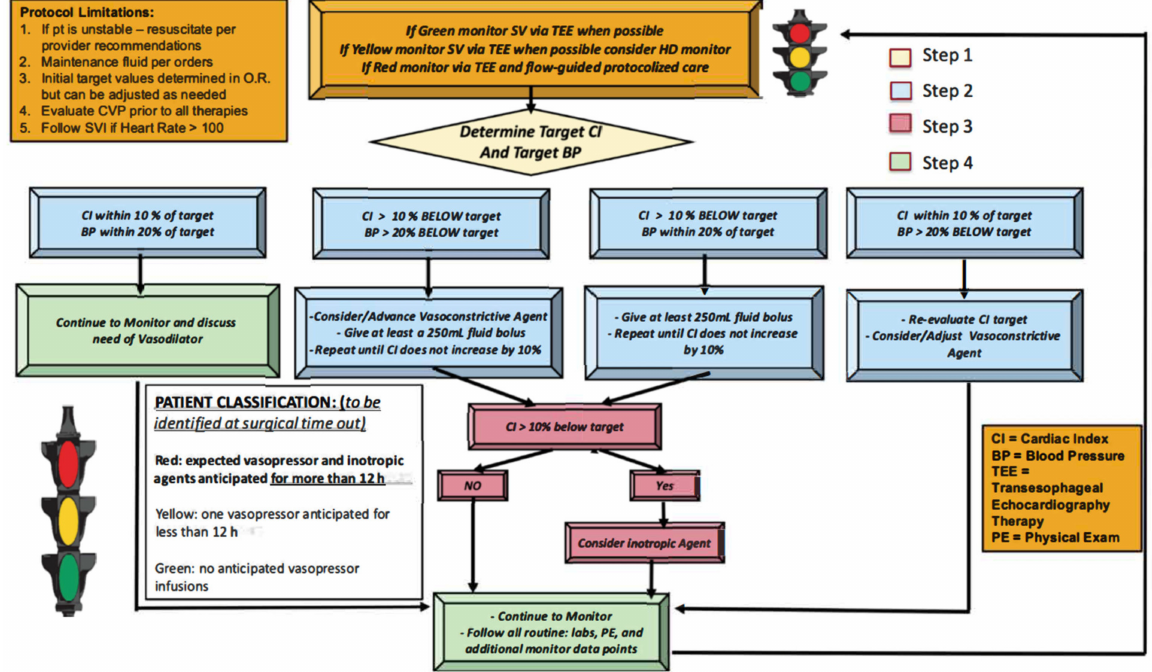
Figure 1. Cardiac hemodynamic optimization protocol. Legend: Stop light system utilized at surgical time out to identify patients with strong likelihood for requiring agents for more than 12 h (left lower box). Target CI and BP determined using multiple monitoring data within 45 min after separating from CPB, steps are followed depending on patient’s CI and BP range (flow chart algorithm; fluid challenge composed of 5% albumin or crystalloid, vasoconstrictive agent composed of norepinephrine, vasopressin, phenylephrine and epinephrine. Inotrope composed of